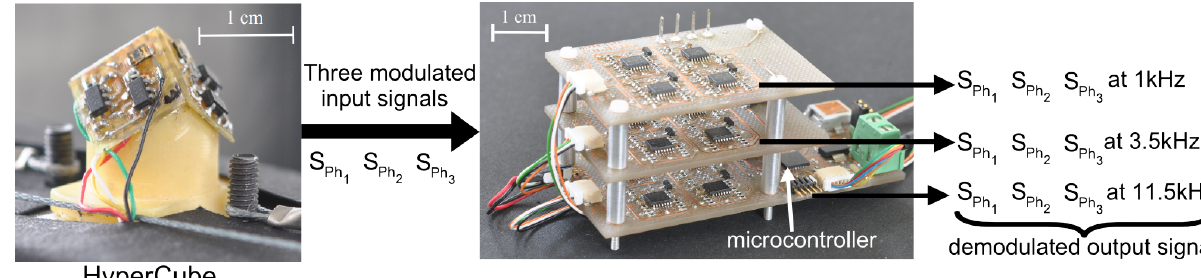
Figure 5. Custom-made acquisition and demodulation board. It is composed of three analog demodulation circuits. A microcontroller processes the visual output signal yielded by HyperCube and provides the azimuth and the elevation, which are sent through a USB interface to a PC. From Figure 6, the angular sensitivity of a photosensor as a blue dotted dashed line is compared to the